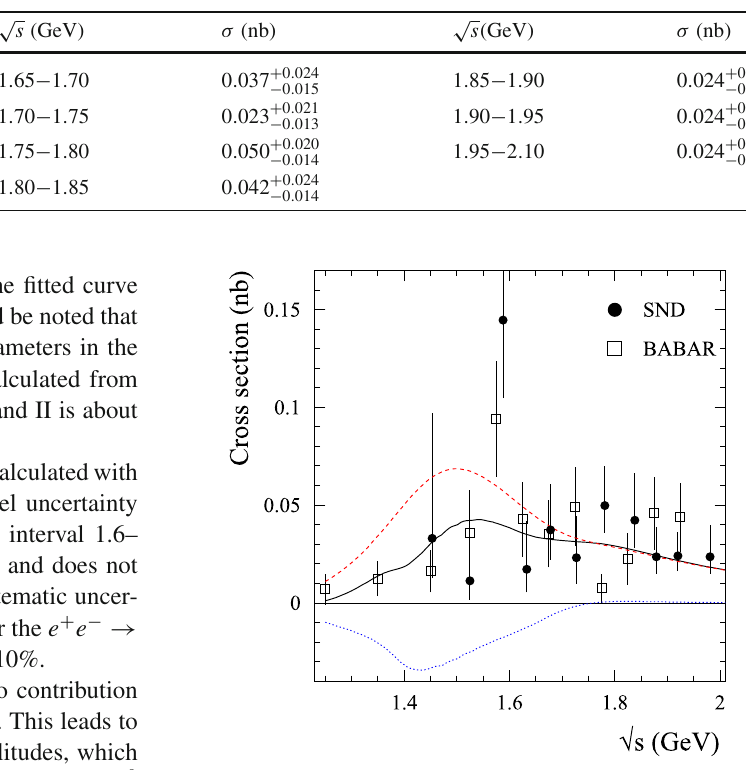
√ s . The quoted errors are